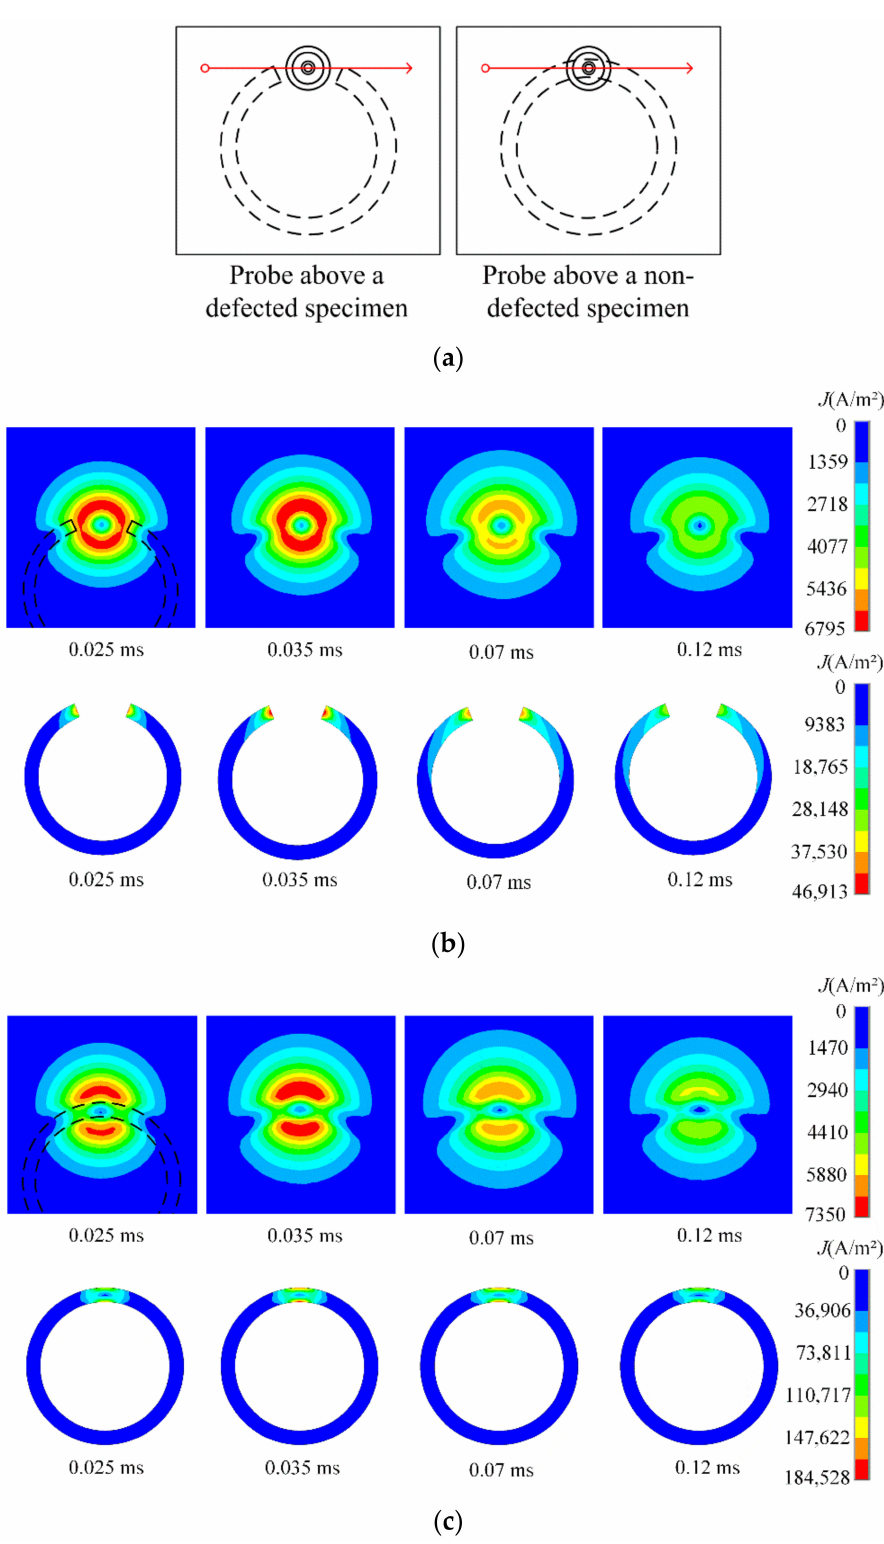
Figure 6. Comparison of the effect of a brazing defect on the induced eddy currents. ( a ) Diagram of probe positions relative to the brazing foil. ( b ) Distribution of eddy currents in the skin plate and brazing foil at four time points when an incomplete brazing is present in the foil. ( c ) Distribution of eddy currents in the skin plate and brazing foil at four time points when the foil is